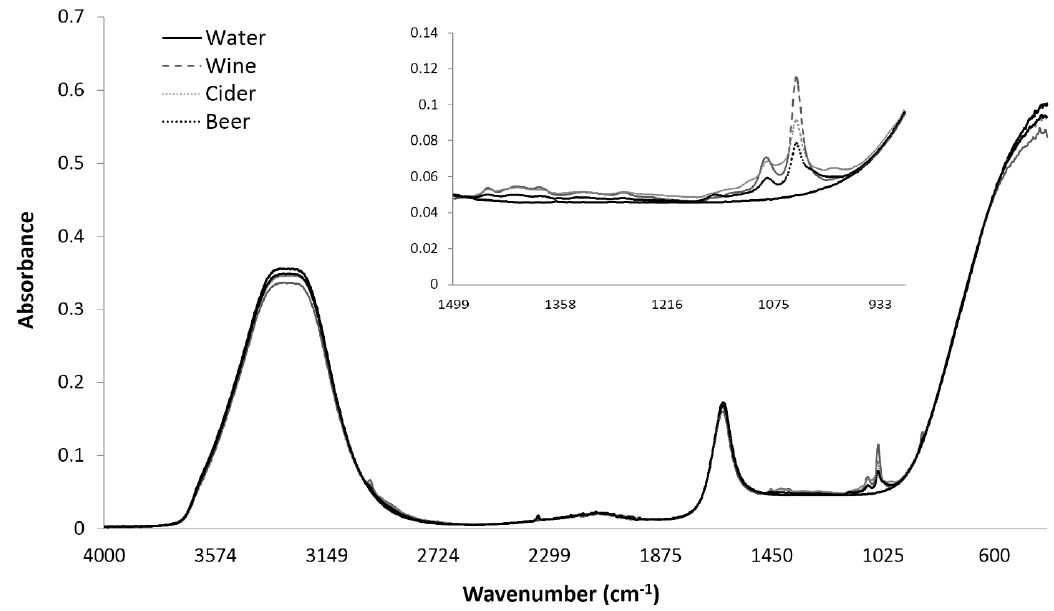
Figure 1. Average ATR ‐ MIR spectra (4000–400 cm − 1 ) for each degassed carbonated beverage: sparkling water ( n = 1), sparkling wine ( n = 1), beer ( n = 4), and cider ( n = 4); ten replicates of each. Most of the variation observed between MIR spectra of the different carbonated beverages occurred within the MIR fingerprint region, i.e., between 1500 and 900 cm − 1 (Figure 1). Multivariate analysis was therefore performed on spectral data from this region and the PCA score plot of the first two principal components (PCs) derived from MIR spectral data is shown in Figure 2; with PC-1 and PC-2 explaining 85% and 10% of the observed variation, respectively. Distinct clustering of the different types of carbonated beverages was observed; with sparkling water samples located near the x -axis on the right side of the score plot, and sparkling wines located in the upper left quadrant. The four beers clustered within the upper right quadrant, while three ciders (ciders A, B, and D, all derived from apple) were located near the y -axis in the lower left quadrant. The remaining pear-based cider (cider C) was somewhat of an anomaly, with samples clustering in the upper right quadrant; i.e., in closer proximity to the beers, rather than the apple-based